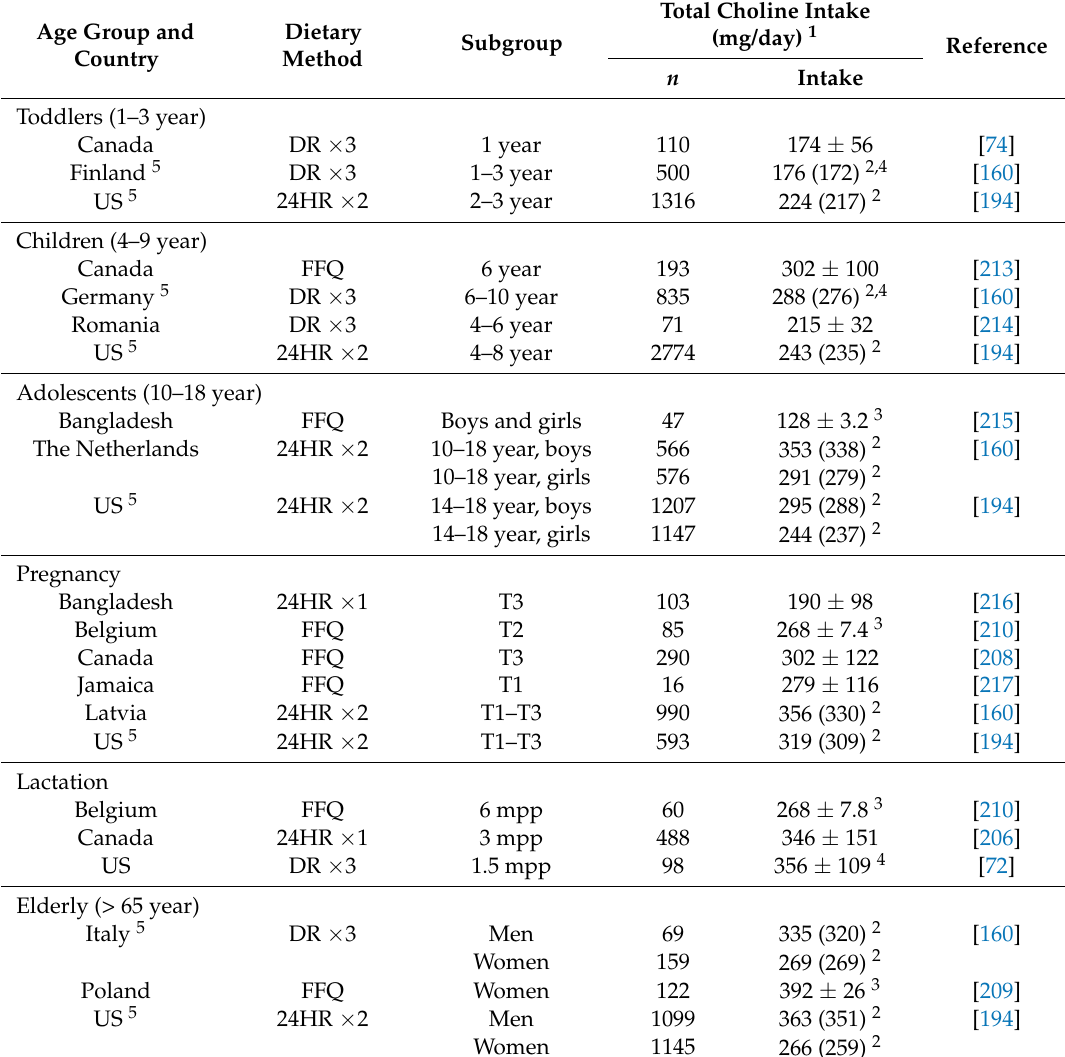
Table 5. Studies reporting on dietary choline intake in other age